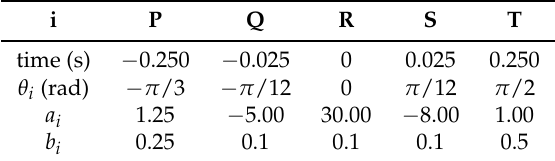
Table 2. Experimental parameters for the McSharry dynamical